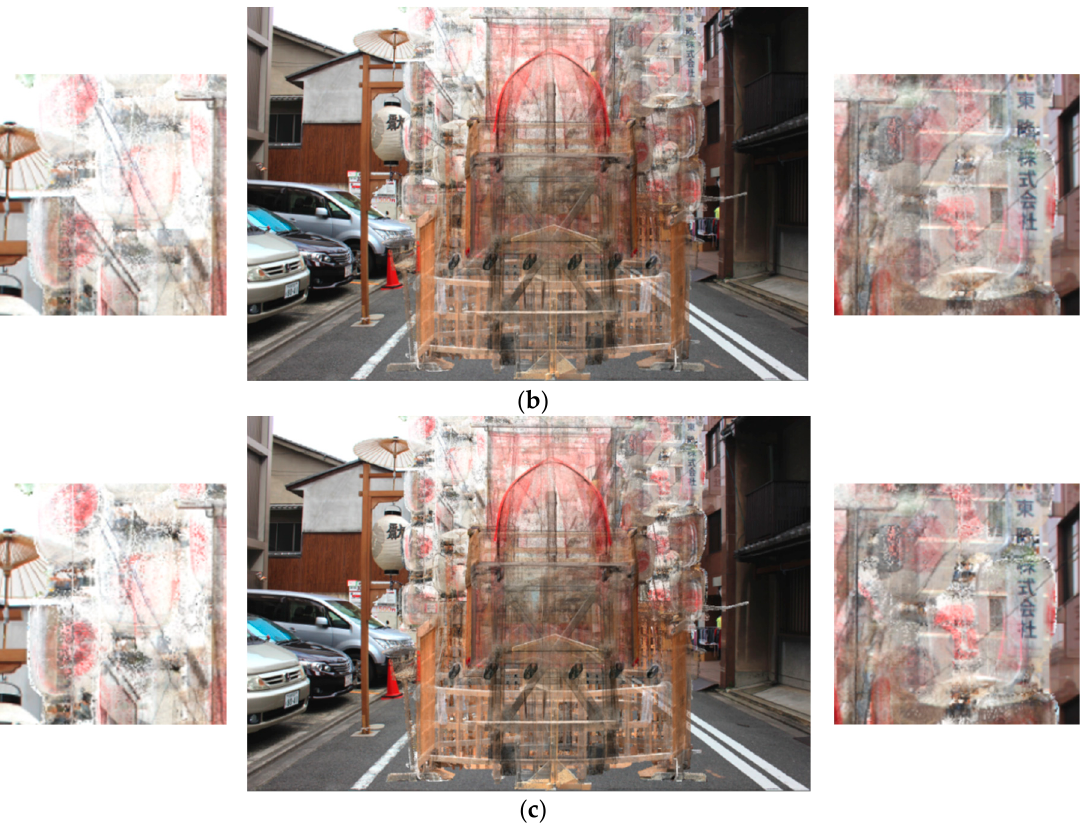
Figure 6. Visualization results of color enhancement with different 𝜇 values: ( a ) 𝜇 = 0.3, ( b ) 𝜇 = 0.6 , and ( c ) 𝜇 = 0.9 .